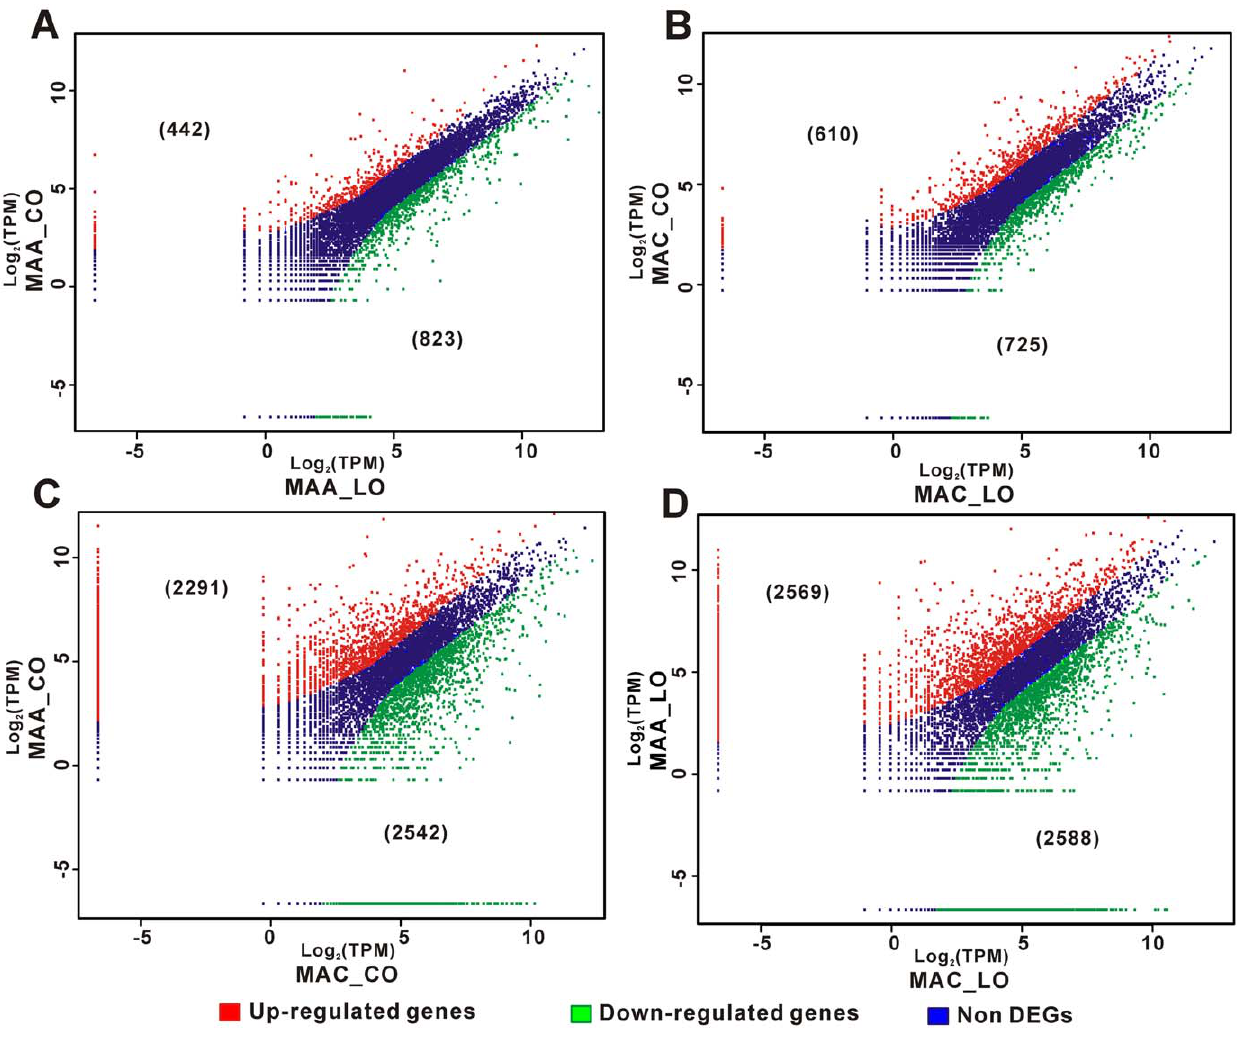
Figure 6. Differential gene expression by M.anisopliae (MAA) and M.acridum (MAC) on locust (LO) and cockroach (CO) hind wings. Genes differentially expressed by M. anisopliae (A) and M. acridum (B) infecting cockroach versus locust cuticles. Genes differentially expressed by M. anisopliae versus M. acridum on cockroach (C) and locust (D) cuticles. The figures in parentheses are the number of genes significantly up- or down- regulated by each